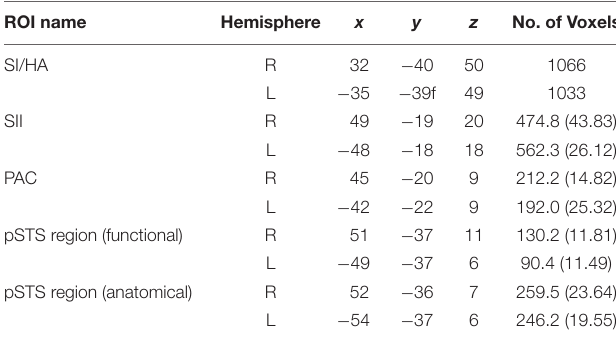
is primarily evident in ED, not NH participants; thus,